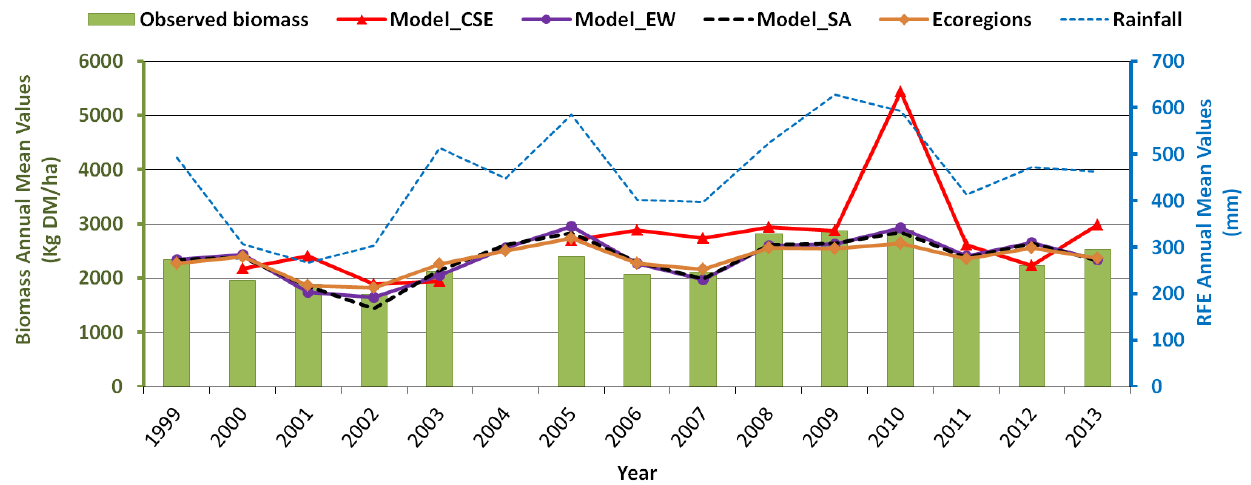
Figure 6. Temporal evolution of the estimated total biomass from CSE and multiple predictor models with regard to observed total biomass, averaged from the monitored sites between 1999 and 2013. Ground data are missing for 2004. Only satellite estimates from SPOT-VEGETATION data are considered ( i.e ., CSE from the year